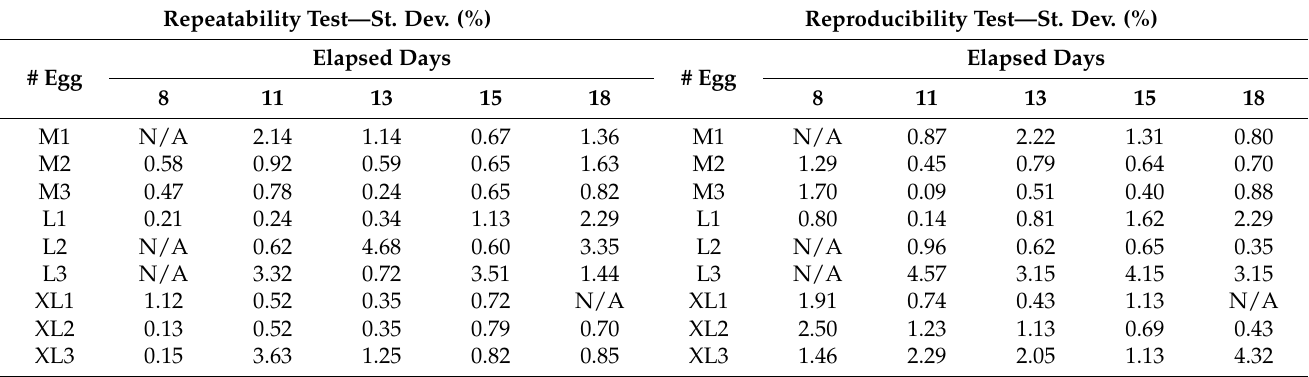
Table 1. Standard deviation of the measured area of the air chamber for repeatability and reproducibility tests.